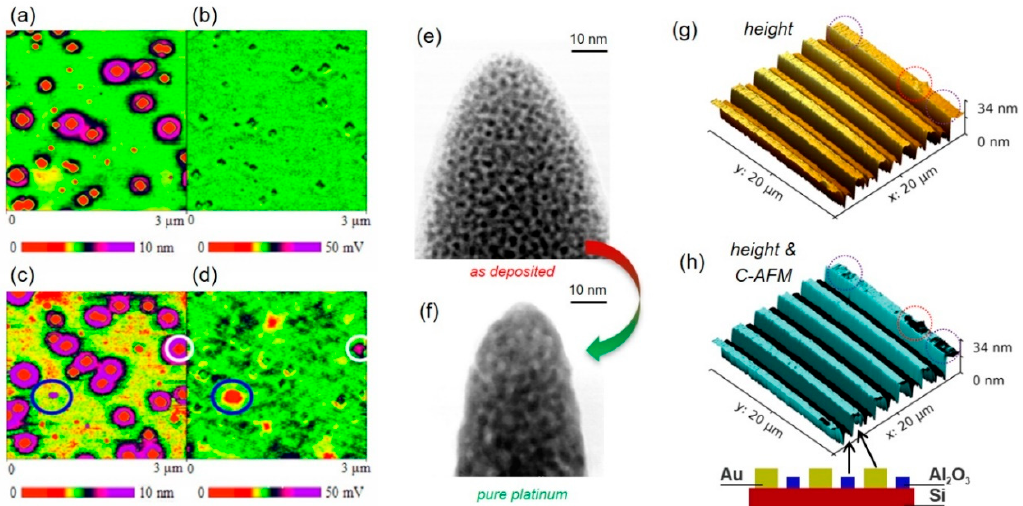
Figure 6. FEBID-based electric AFM modes. ( a – d ) show height (left) and Kelvin force microscopy (KFM) (right) images of SiGe quantum ring, performed with commercial, Pt–Ir coated AFM tips (upper row) and Pt–C nano-pillar modified tips (lower row). While the resolution improvement is evident by the more circular feature shapes, the KFM images reveal many more details, as representatively indicated by the blue and white rings. Adapted and reprinted from Chen et al., IEEE 2012 [94]. ( e , f ) show TEM micrographs of the tip region of a Pt-based FEBID nano-pillar after deposition ( e ) and after full purification using e-beam assisted carbon removal in H 2 O atmospheres at room temperature [44,90]. As evident, the pillar gets smaller in width, which entails a slight reduction of the apex radius in the sub-10 nm regime. The larger Pt crystals and the dense packing are evident, while the carbon-free character was confirmed by scanning transmission electron microscopy-based electron energy loss spectroscopy (STEM-EELS) measurements. Such highly conductive tips are then used for C-AFM measurements, as representatively shown in ( g , h ). The scheme below shows the layer setup, consisting of Au paths separated by Al 2 O 3 lines on Si. The advantage of the high aspect ratio pillar is an accurate edge profiling in the height image ( g ), while the current signal (skin overlay in ( h )) allows for the identification of non-conductive regions of thick (red circles) and nanometer thin (purple rings) impurity layers. Image copyright GETec Microscopy 2019 [95].